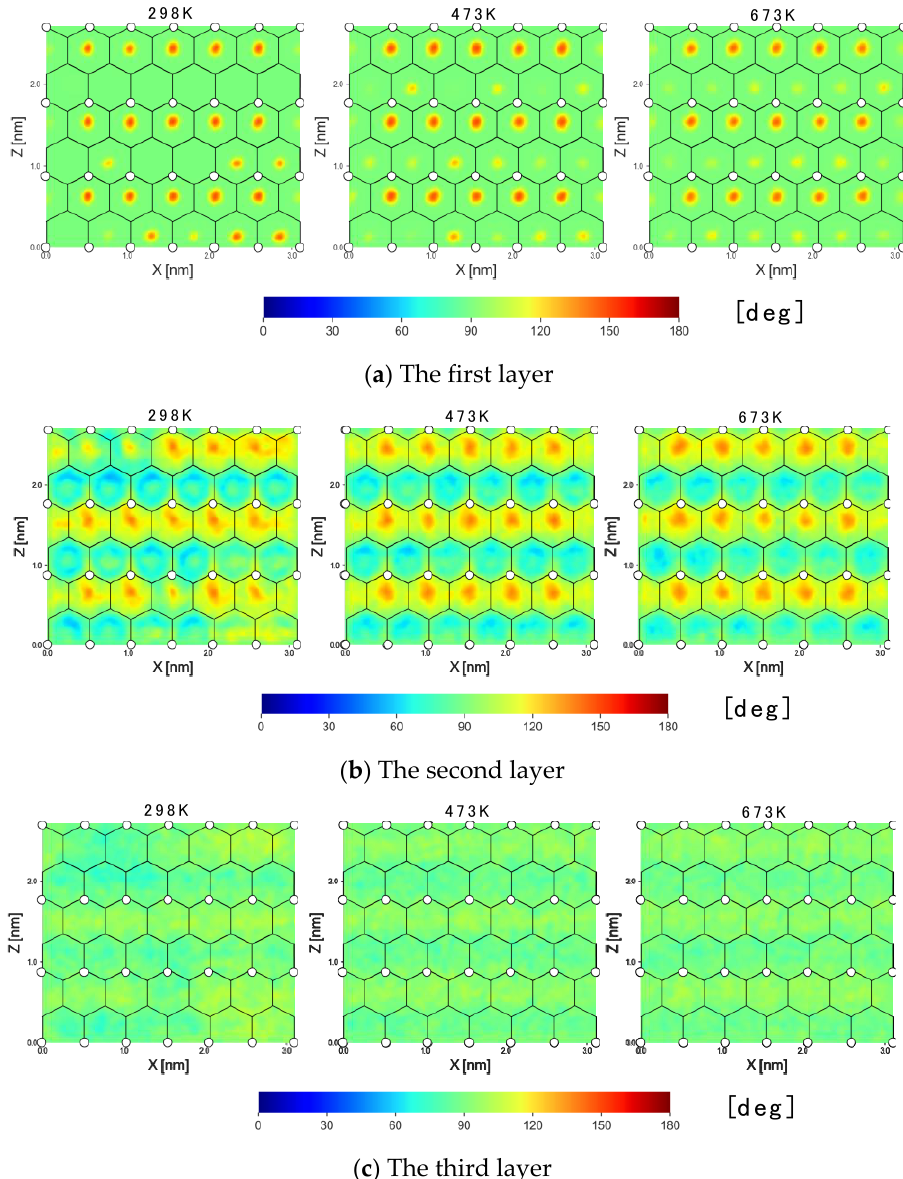
Figure 9. 2D Maps of the orientation angle 𝜃 at 50 MPa; the lattice on the map is from Figure S6 in Supplementary Materials.